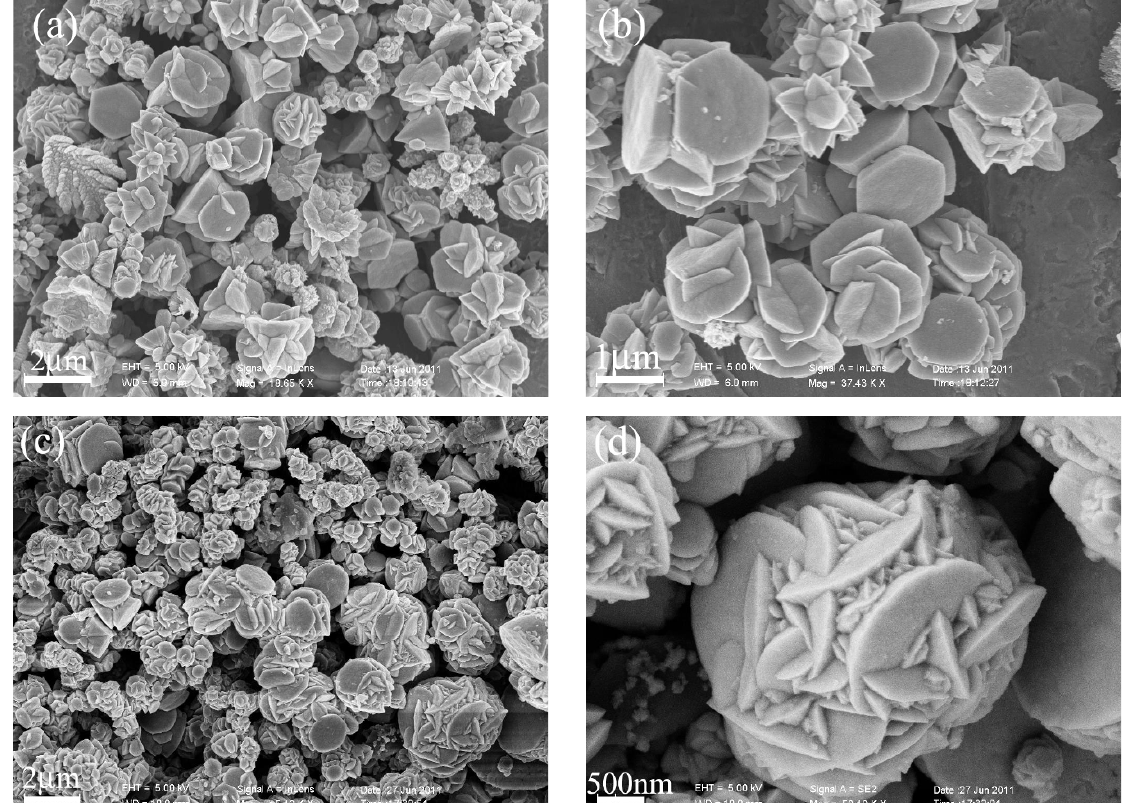
Figure 3. (a) A low magnification FESEM image of the CdS flower-like architectures obtained at 140 o C; (b) a high magnification FESEM image of the CdS flower-like architectures obtained at 140 o C; (c) a low magnification FESEM image of the CdS flower-like architectures obtained at 200 o C; (d) a high magnification FESEM image of the CdS flower-like architectures obtained at 200 o have different morphologies. Fig. 4b shows that the size of the nanoplates is not uniform. When lauryl mercaptan is used as the sulphur source, the products are composed of many ball-flowers, but the size is different, shown in Figs. 4c and 4d. Apart from reaction temperature and starting materials, solvent also plays an important role in the formation of the high yield and uniform flower- like CdS architectures. With other conditions kept as constant, Fig. 5 shows that in the control experiment, different morphologies of the products could be achieved by adjusting solvent. It can be clearly observed that the size and shape of CdS depend on the type of solvent used. Fig. 5a shows the products synthesized in 40 mL ethylene glycol are nanoparticles with diameter of about 30 nm. The products synthesized in 30 mL ethylene glycol and 10 mL oleic acid as solvent (Fig. 5b), are composed of large amounts of flower-like architectures with the size ranging from 0.5 to 2 µm, which is similar to the result in Fig. 2 . A FESEM image of the products obtained using 10 mL ethylene glycol and 30 mL oleic acid as solvent (Fig. 5c), displays polyhedral structures,